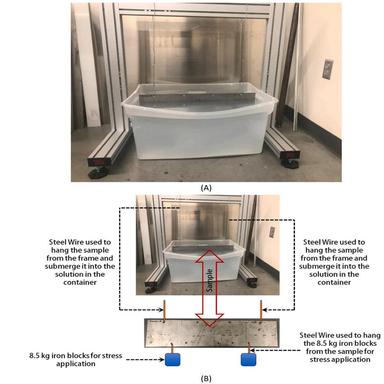
Laboratory scale test setup for SCC; (A) test setup showing the container of the solution and the sample submerged into the solution hanging by steel wires from the top of the frame, (B) schematics of the sample and distribution of added masses for applying stress to the sample.